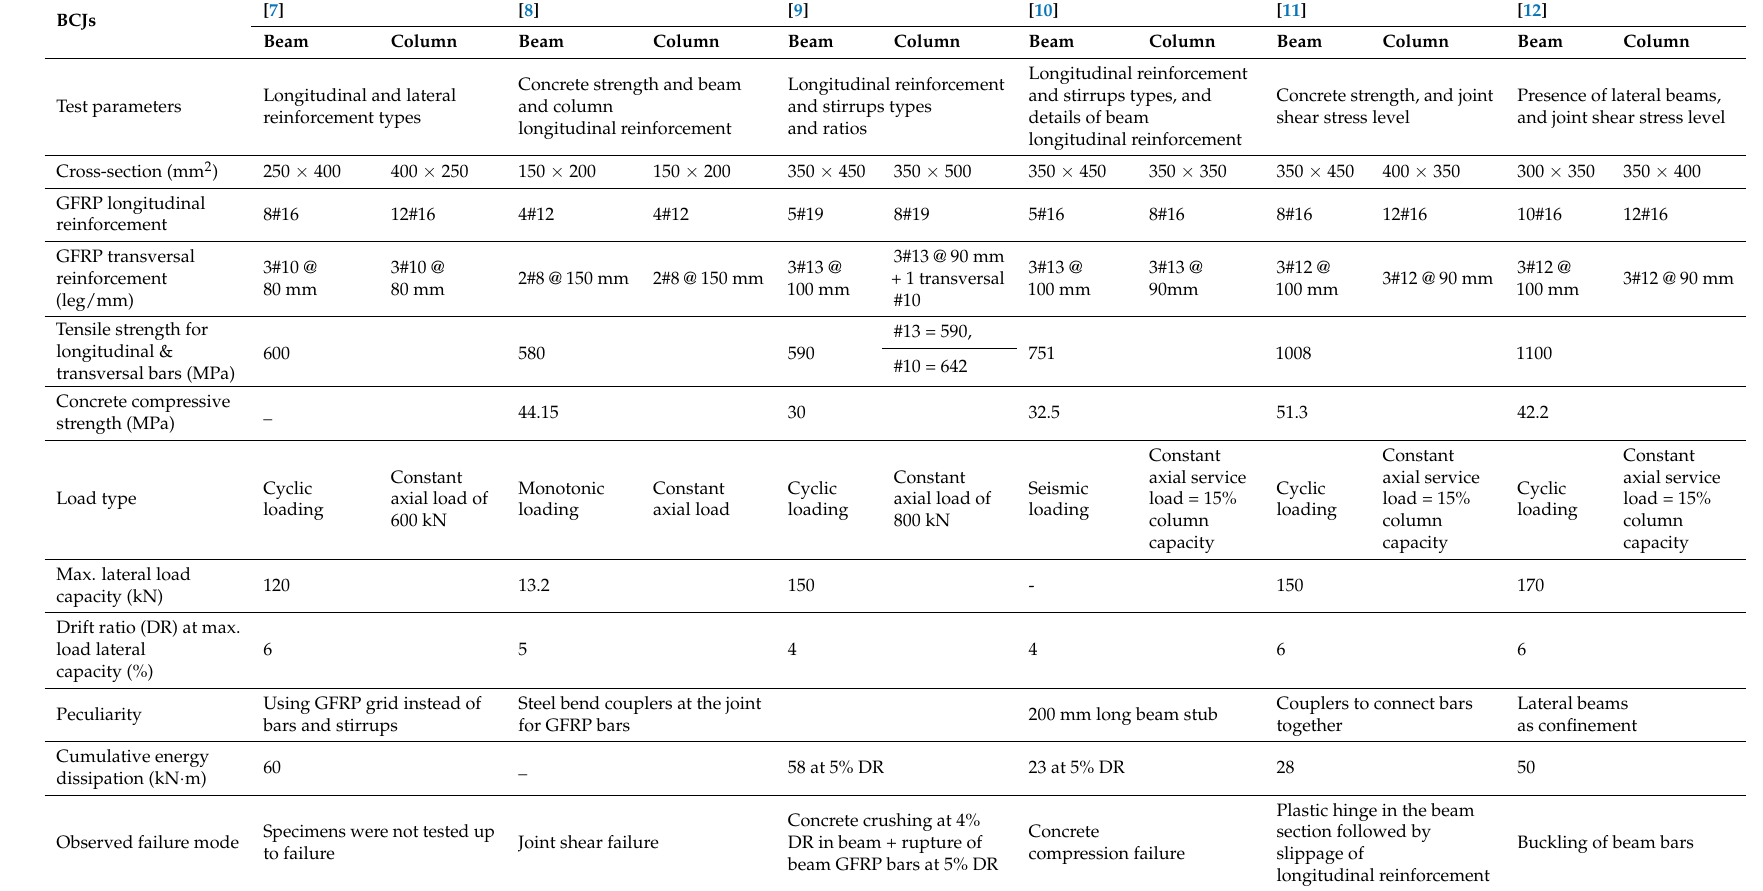
Table 1. Summary of experimental work on BCJs internally reinforced with